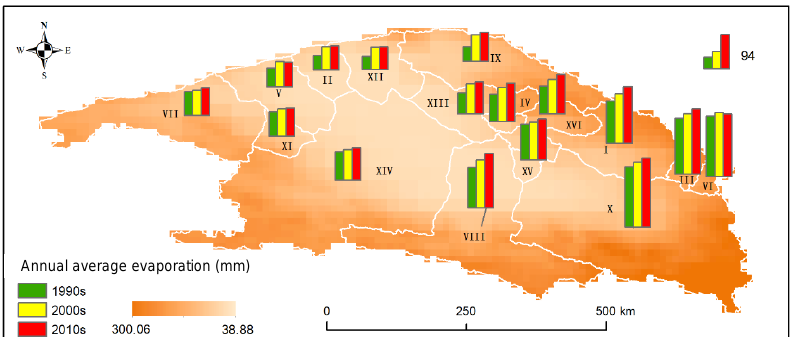
Figure 9. Spatial pattern of evaporation in the Qaidam Basin from 1990 to 2020. Green, yellow, and red histograms represent the annual average evaporation for different decades in each WRZ, with a scalar in the upper right corner. Table 6. Test results of the air temperature trend in the Qaidam Basin from 1990 to 2020.